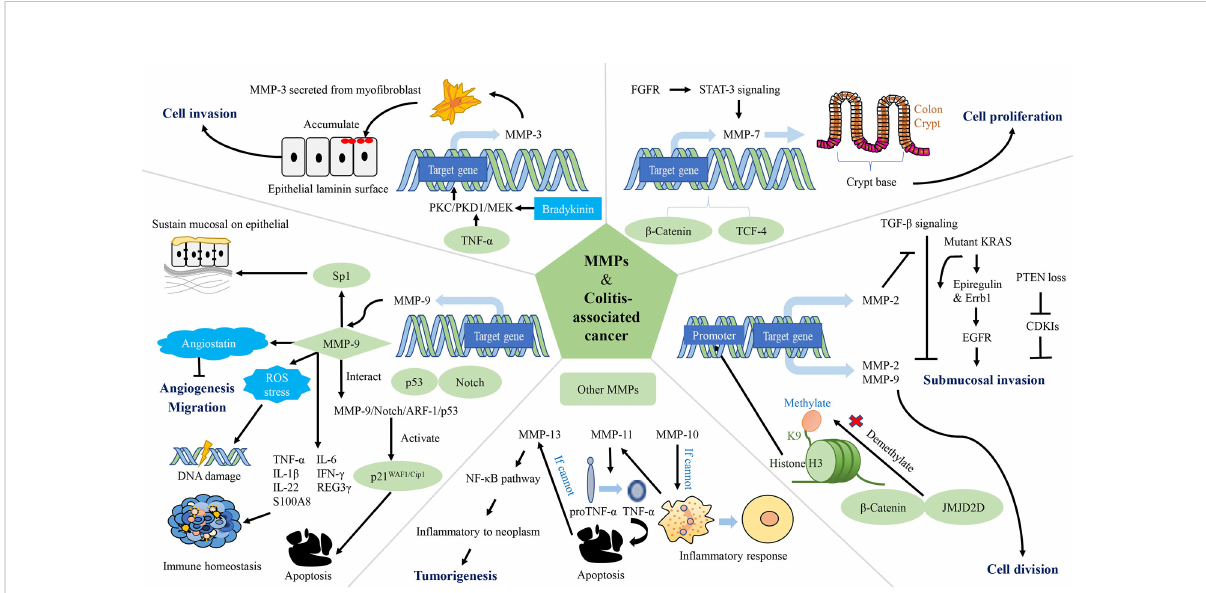
FIGURE 3 The network of matrix metalloproteinases (MMPs) interfering with colitis-associated cancers (CAC). MMP-2, MMP-3, MMP-7, MMP-9, MMP-10, MMP-11, and MMP-13 are involved in the regulation of CAC. MMP-2 and MMP-9 promote CRC cell proliferation. MMP-2 and MMP-3 contribute to tumor invasion. Expression of MMP-9 leads to apoptosis, reduced accumulation of ROS, DNA damage and inhibition of tumor vascularization, while maintaining epithelial mucosa, microbiota homeostasis and immune homeostasis. MMP-10 plays a role in in fl ammation regression. MMP- 11 reduces apoptosis in cancer cells. PKC/PKD1/MEK: protein kinase C/protein kinase D1/mitogen-activated protein; TCF-4: T-cell factor-4; PTEN: phosphatase and tensin homolog deleted on chromosome 10; EGFR, epidermal growth factor receptor; FGFR, fi broblast growth factor receptors; CDK, cyclin dependent kinase; Sp1, speci fi city protein 1; ROS, reactive oxygen